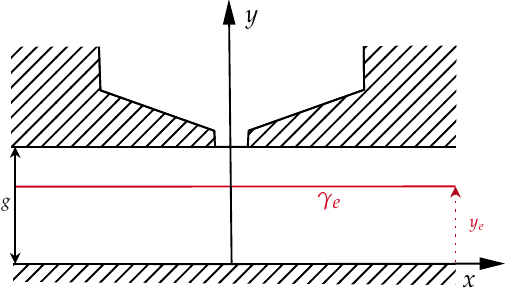
τ t / 2 τ t / 2). x − ≤ ≤ in front of a slot opening b so = 6 mm. M